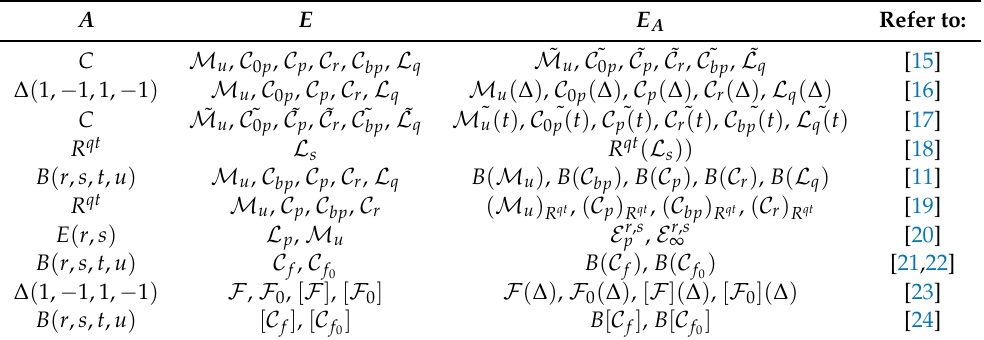
Table 1. The domains E A of some 4D triangle matrices A in a certain double sequence space E